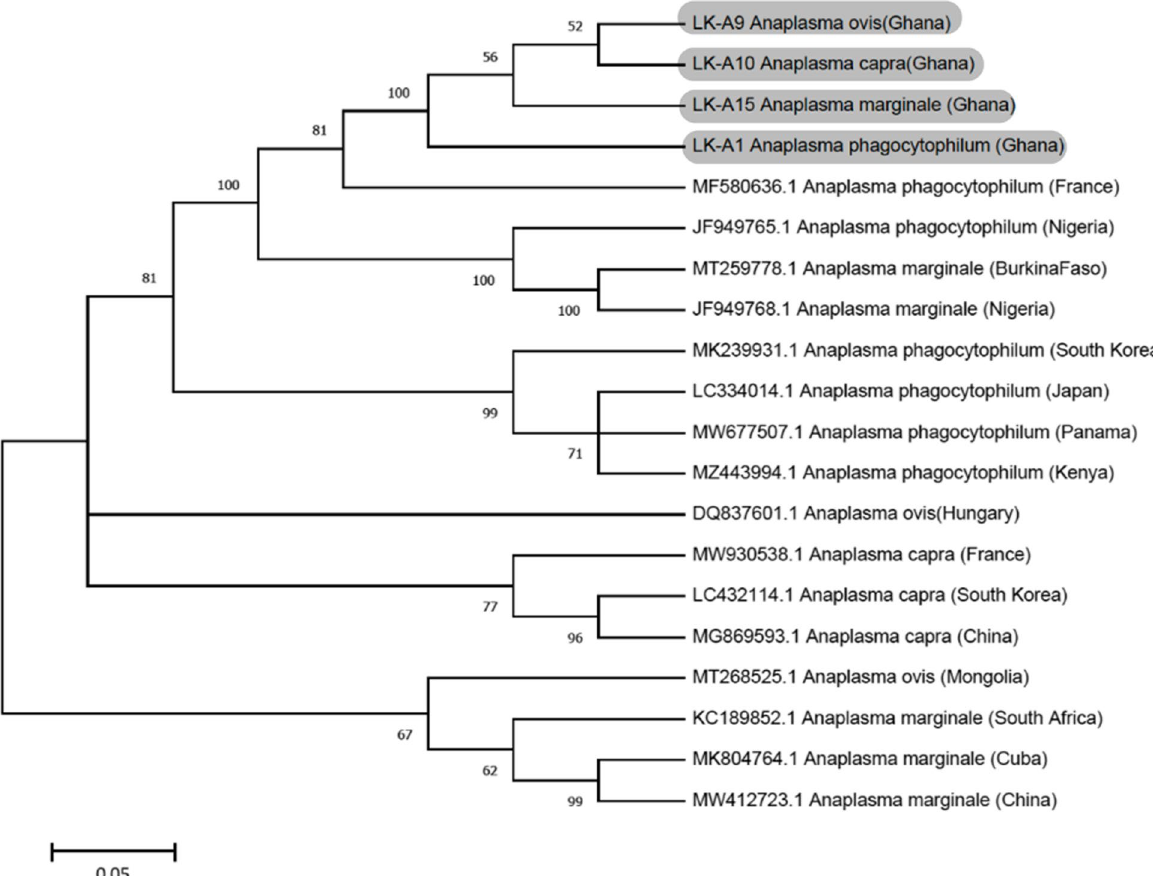
Table 3 Bacterial and parasitic pathogens in association with livestock characteristics Total livestock Bacterial Parasitic Bacterial/Parasitic (%) Single infection Coinfection P -value Single infection P -value Single